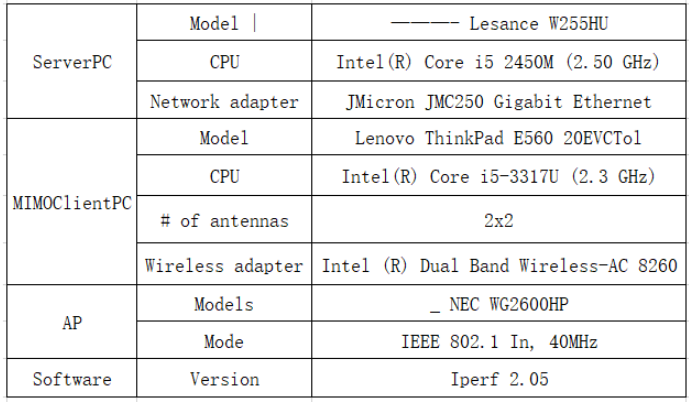
Figure 10. Excel table after merging the same